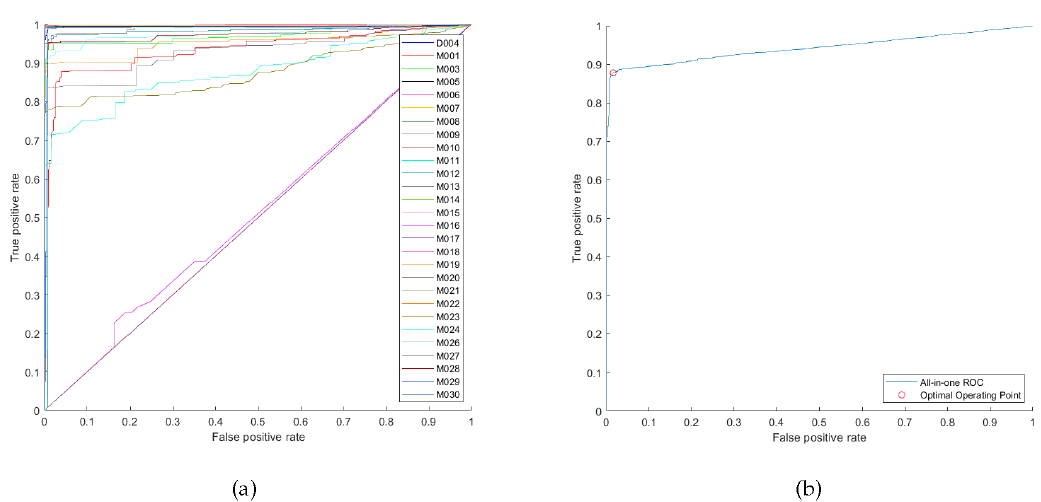
Figure 8. Using sliding window size of 30 s, minimum relative support 15% and minimum confidence of 60%: ( a ) ROC curves of failure detection when each consequent sensor has fail-stop failure. ( b ) All-in-one ROC